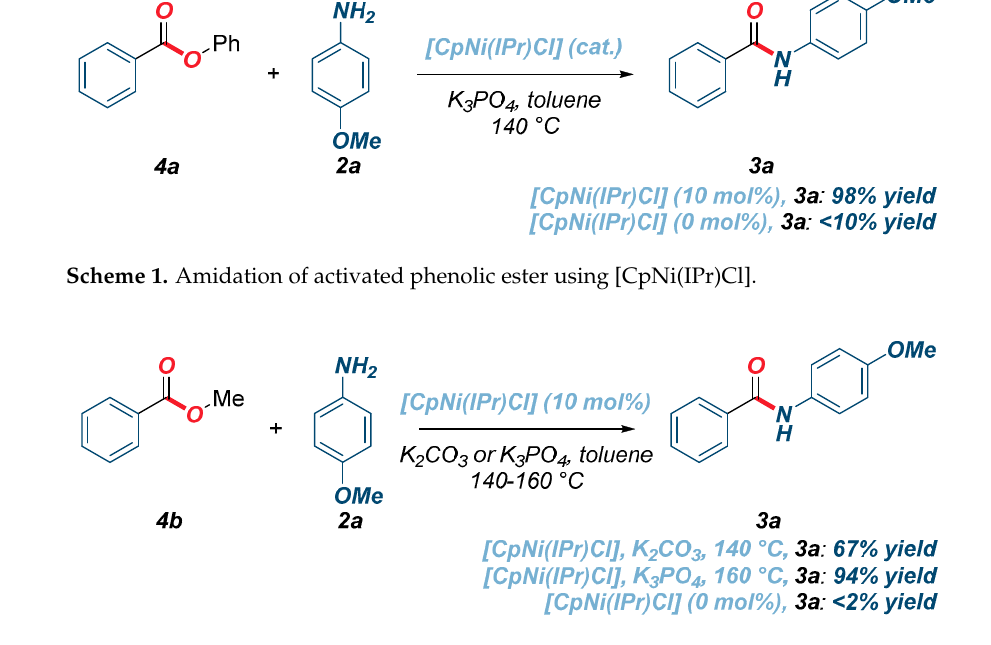
Figure 3. Kinetic profile of 1a . Conditions: 1a , 4-MeO-C 6 H 4 -NH 2 (2.0 equiv), [CpNi(IPr)Cl] (10 mol%), K 2 CO 3 (3.0 equiv), toluene (0.25 M), 140 °C, 0–18 h.